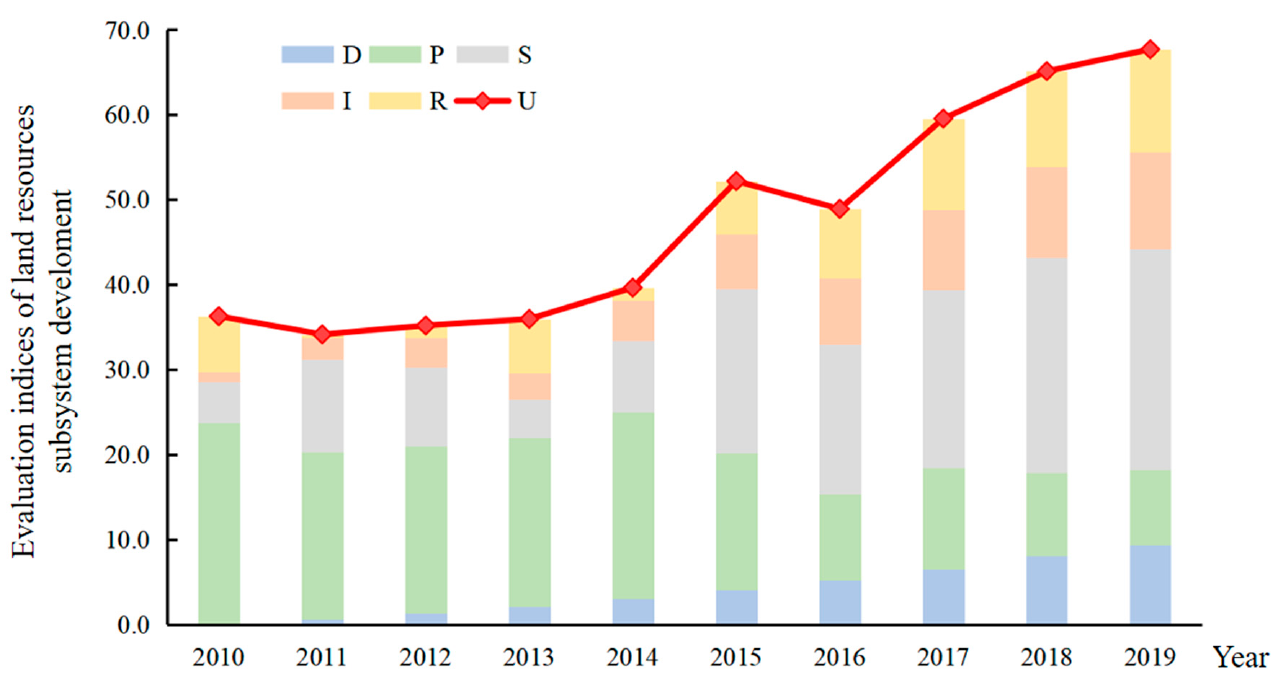
Figure 5. Trends of the development level of the water resources.